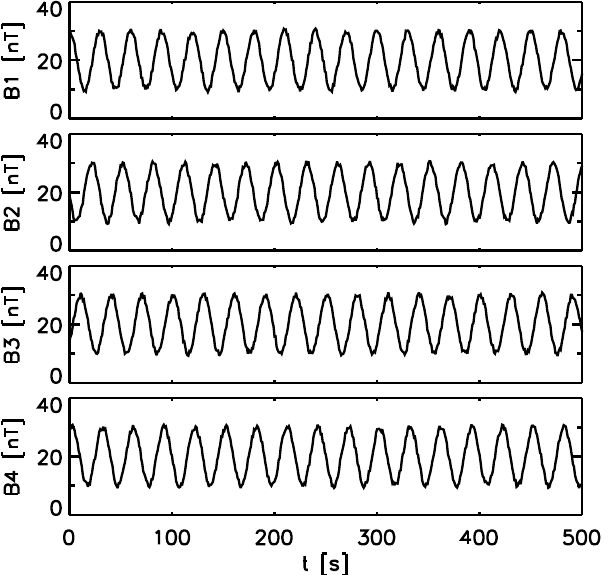
Fig. 1. Synthetic scalar magnetic field data at four points. The data set is used for Capon’s method and the MSR technique displayed in Fig. 2.